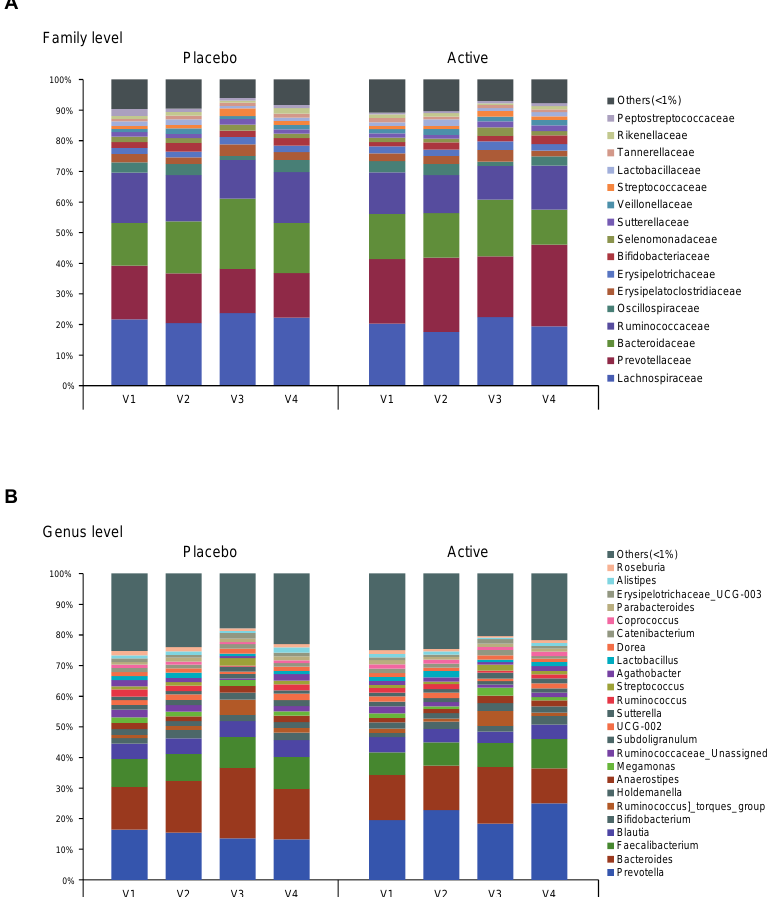
Figure 3. Taxonomy composition of each group. Bar plots on relative abundances of OTUs annotated at the ( A ) family and ( B ) genus level. An average <1% is labeled as others. Each bar represents the different group (v1, visit1; v2, visit2; v3, visit3; v4, visit4). OTUs, operational taxonomic units.